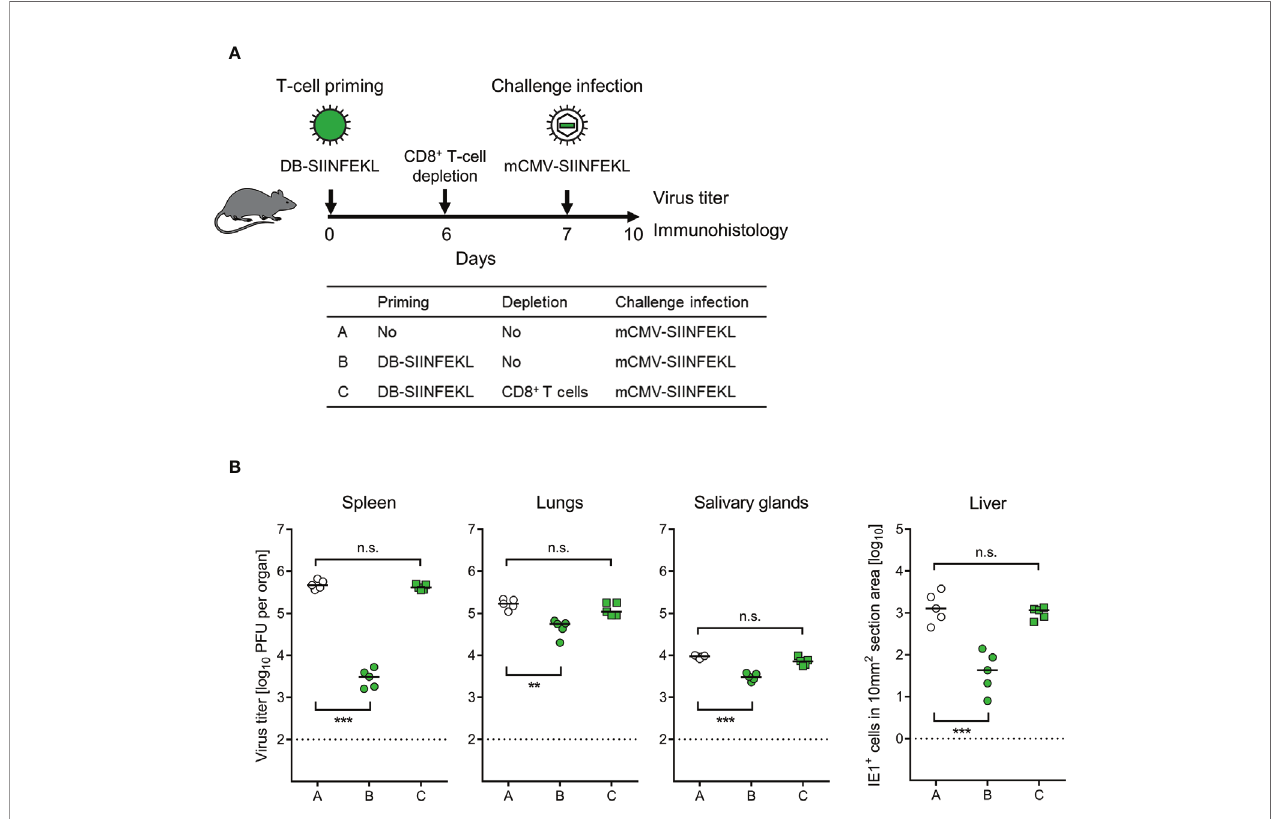
FIGURE 7 | Identi fi cation of the protective T-cell subpopulation. (A) Sketch of the protocol and table of experimental groups A – C. Immunocompetent C57BL/6 mice were primed (vaccinated) by intraplantar application of 20- m g doses of DB-SIINFEKL. CD8 + T cells were depleted on day 6, followed by high-dose (10 6 PFU) intravenous challenge infection with mCMV-SIINFEKL on day 7. Control of organ infection was assessed on day 10. (B) Virus titers in spleen, lungs, and salivary glands, as well as numbers of infected IE1 + liver tissue cells in representative 10-mm 2 section areas. Symbols (open circles: no vaccination; green closed circles: vaccination with DB-SIINFEKL; green closed squares: vaccination with DB-SIINFEKL followed by depletion of CD8 + T cells) represent data from individually tested mice, with the median values marked. Signi fi cance levels (**) P < 0.01, (***) P < 0.001, (n.s.), not signi fi cant ( P > 0.05). Dotted lines, detection limits of the